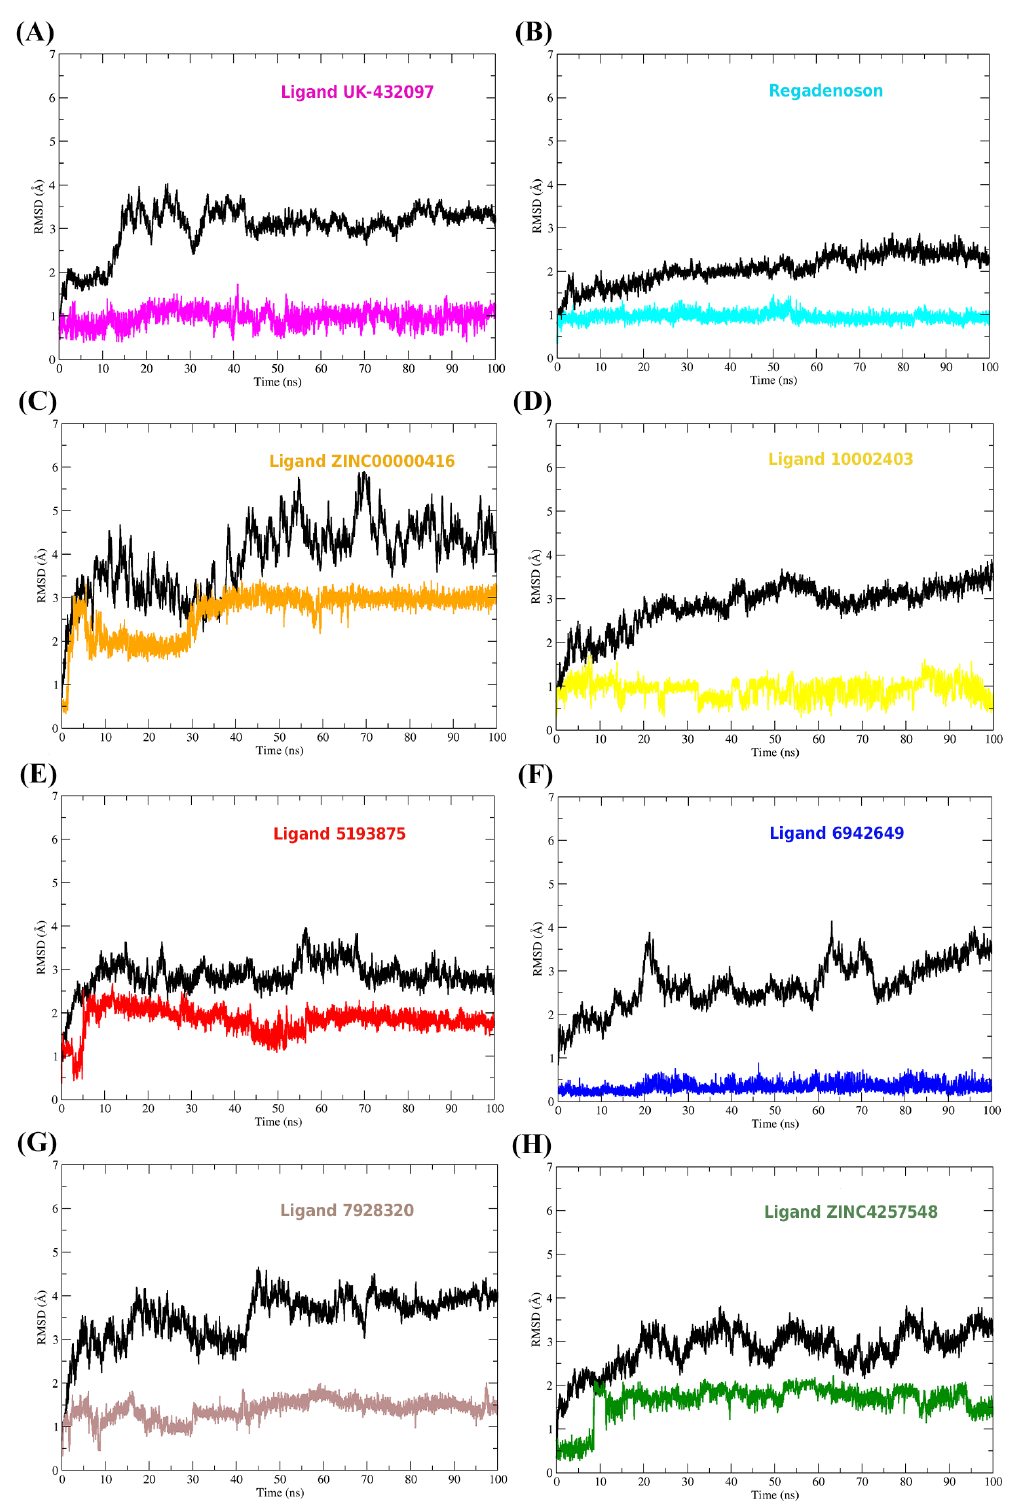
Figure 12. RMSD plot along the path of MD simulations. The protein backbone plot is colored black, but the ligand plots are colored in different ways. ( A ) RMSDs of the A 2A AR-UK- 432097 system, ( B ) RMSDs of the A 2A AR-Regadenoson system, ( C ) RMSDs of the A 2A AR-ZINC00000416 system, ( D ) RMSDs of the A 2A AR-Ligand 10002403 system, ( E ) RMSDs of the A 2A AR-Ligand 5193875 system, ( F ) RMSDs of the A 2A AR-Ligand 6942649 system, ( G ) RMSDs of the A 2A AR-Ligand 7928320 system and ( H ) RMSDs of the A 2A AR-ZINC4257548 system.